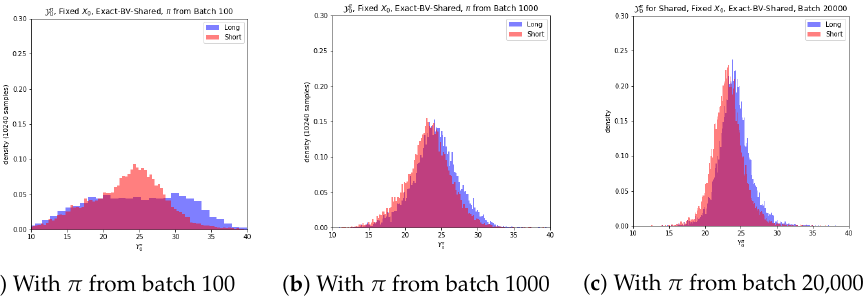
Figure 6. Distribution of the rollback Y π for strategies of certain batches in the optimization. Straddle. 0 Backward method with exact backward step. Single DNN for π . Batch size